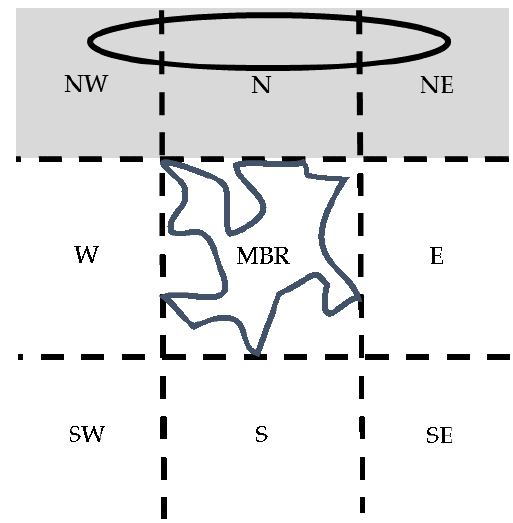
Figure 3: An example of two objects A and B , such that the MBR of B generates a partition of space, and A qualitatively intersects it, forming its direction relation